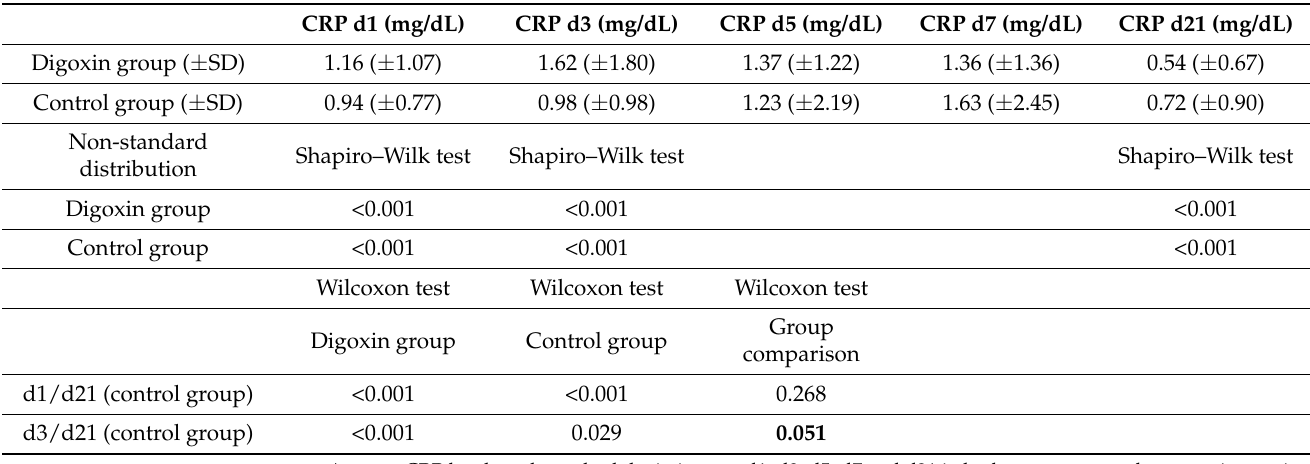
Table 2. CRP levels, normal assumption testing and CRP drop-off